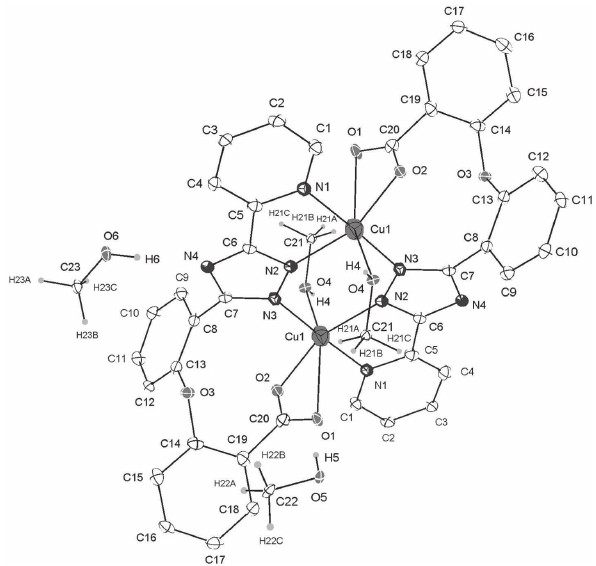
Table 2: Fractional atomic coordinates and isotropic or